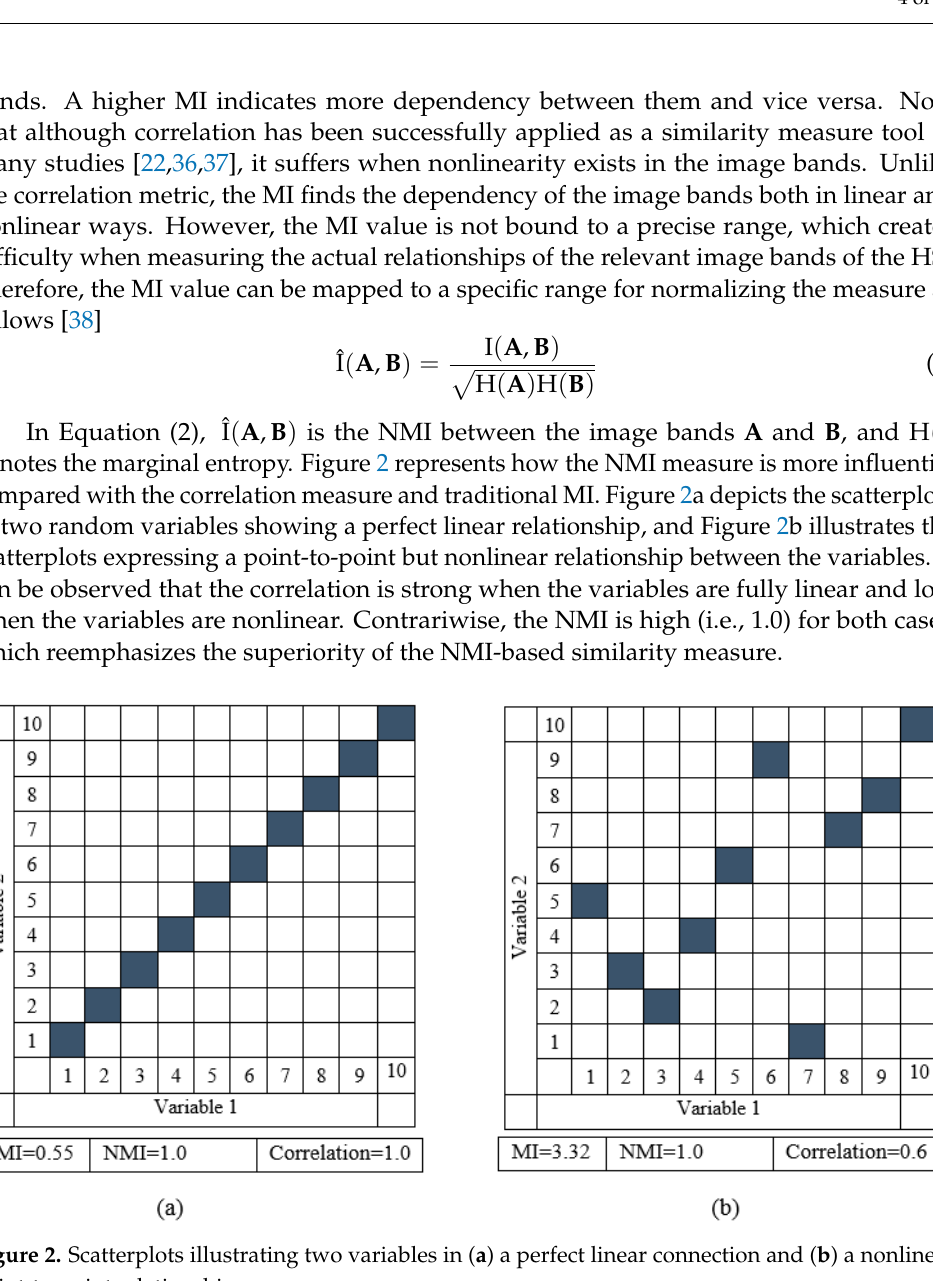
Figure 2. Scatterplots illustrating two variables in ( a ) a perfect linear connection and ( b ) a nonlinear point-to-point relationship.